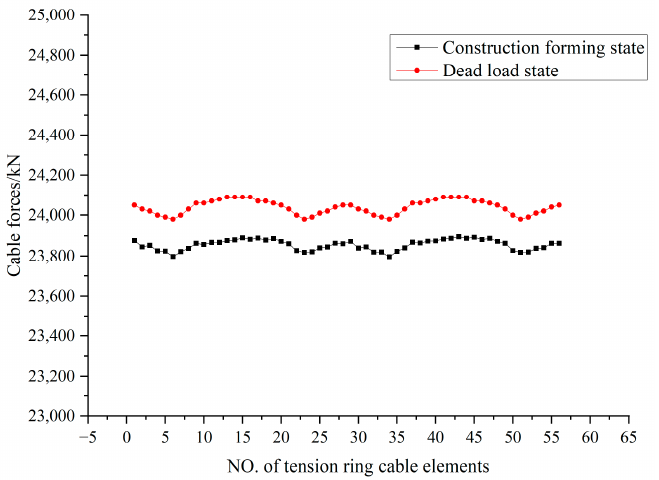
Figure 59. Comparison curve of tension ring force in two states (kN).